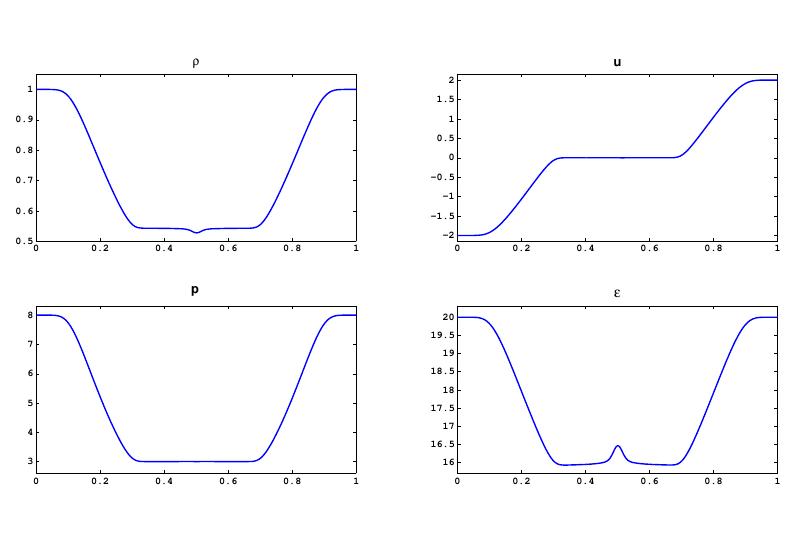
Figure 5. Test 3 (the stiffened gas): the space graphs at time t fin = 0 .